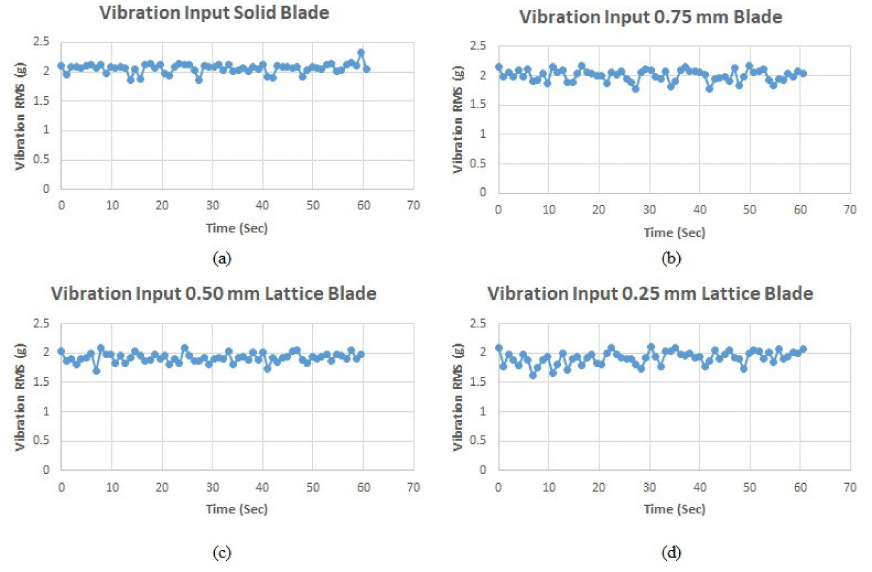
Figure 9. Input vibration signal for blades: ( a ) the solid blade; ( b ) the 0.75 mm lattice blade; ( c ) the 0.50 mm lattice blade; ( d ) the 0.25 mm lattice